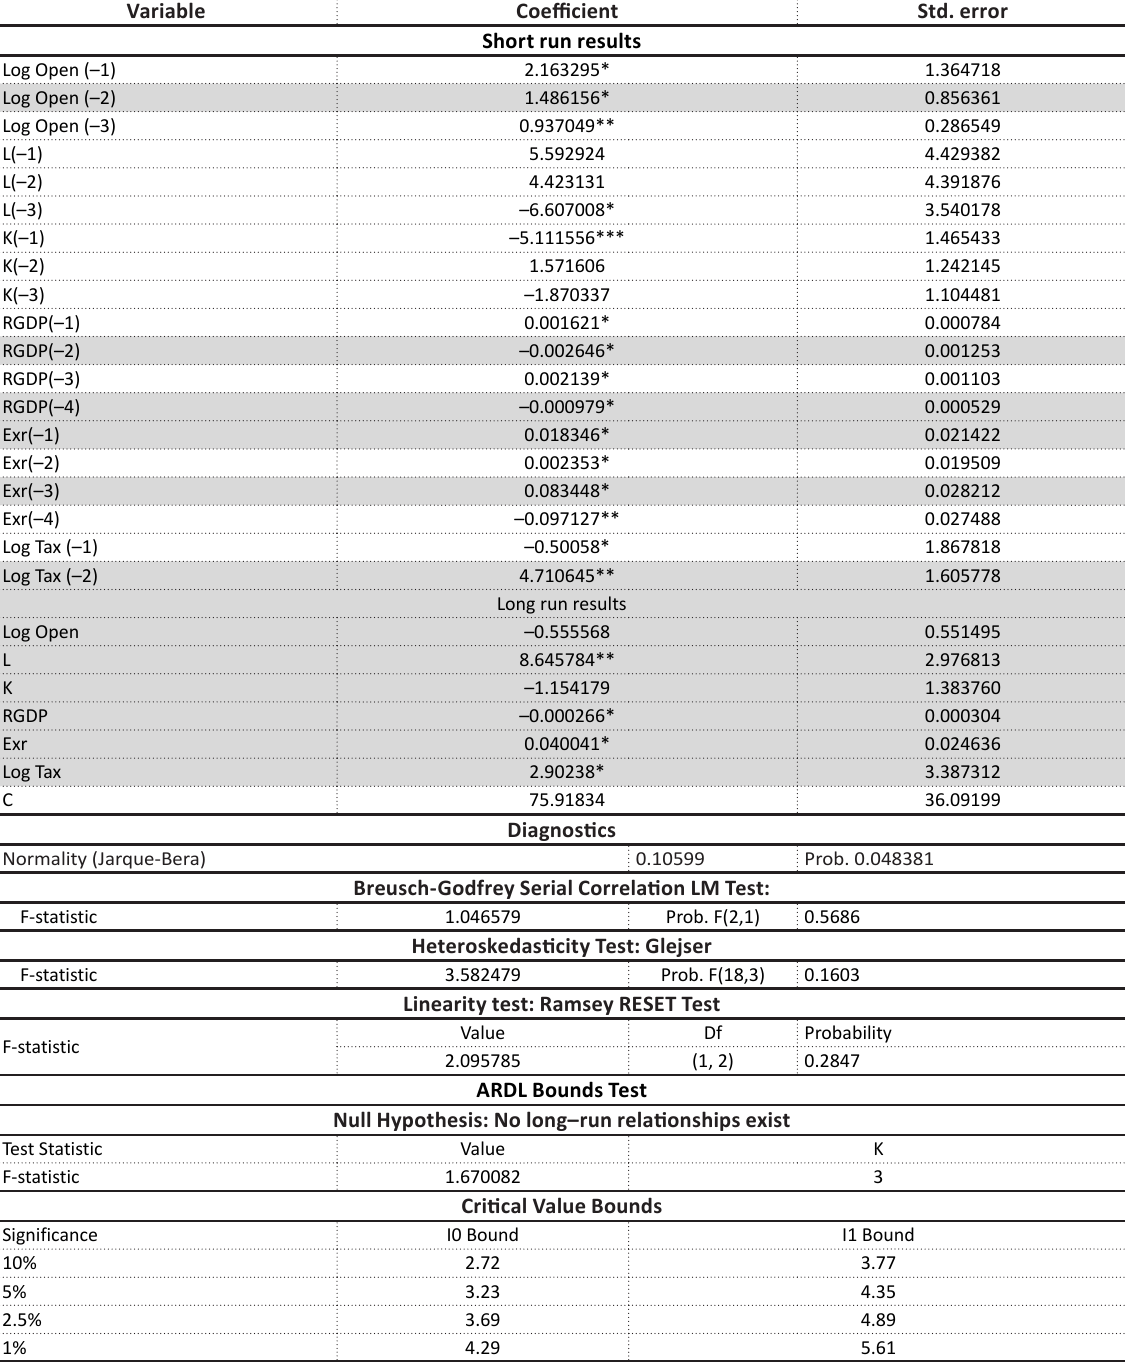
Table 4. Estimates of the ARDL model for the effect of trade openness on SME performance in Nigeria Variable Coefficient Std. error Short run